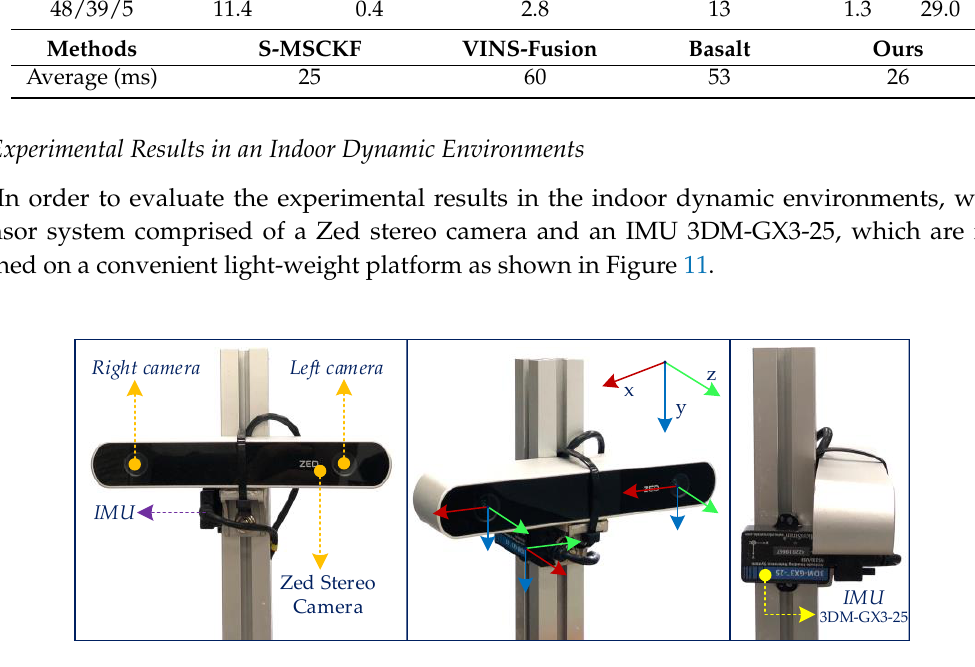
Figure 11. The hardware setup consists of a stereo Zed camera and an inertial sensor